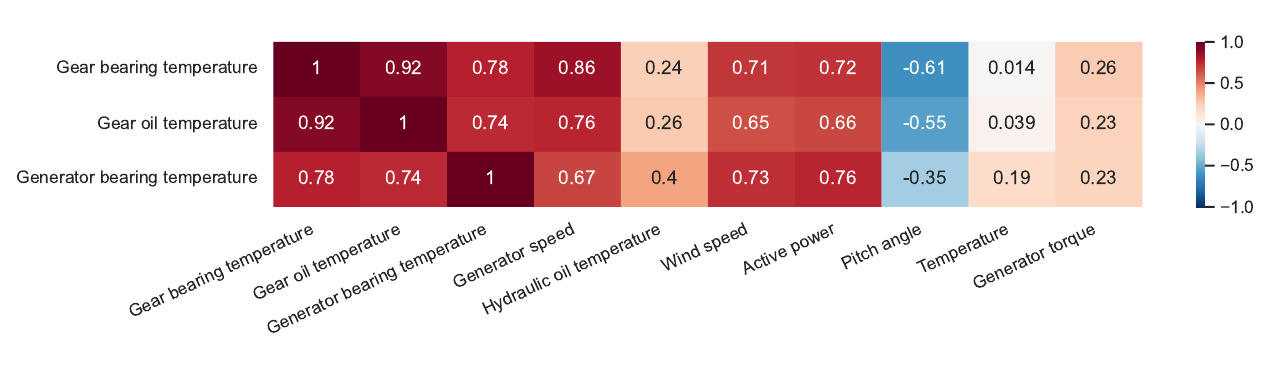
consists of multiple timestamps, the target value corresponds to just one timestamp: the final timestamp of the corresponding input sample. Given the number of timestamps and input features, the input shape of each sample is 6 × 9. This can be seen schematically in Figure 5. The model is trained by minimizing the mean squared error (MSE). This loss function was chosen so that high errors in the prediction are penalized more compared to other loss functions like the mean absolute error. The training was done over 100 epochs, but was stopped early if the validation loss did not improve over 10 epochs. This was done to prevent overfitting. The model was implemented and trained by using Keras [49], and the details of its architecture are reported in Figure